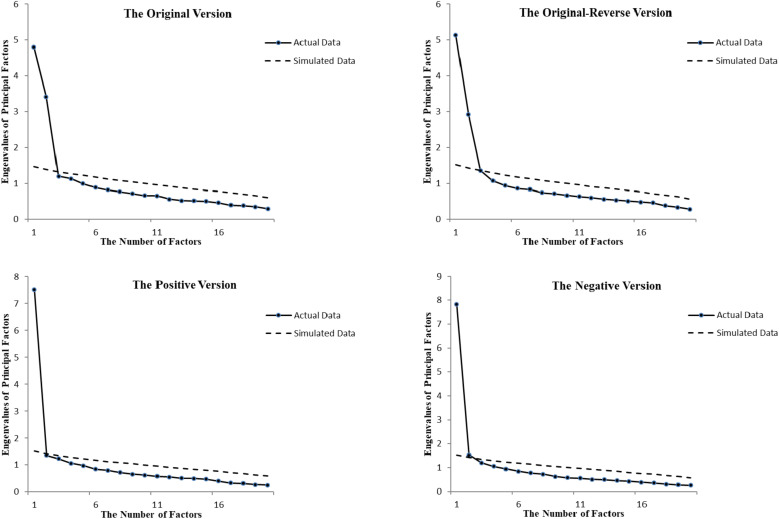
The solid lines represent scree plot obtained from the actual data. The dashed lines are scree plot averaged across 50 data points in a simulated dataset generated from a population, where all variables are uncorrelated, with the same number of participants and items as the original dataset.